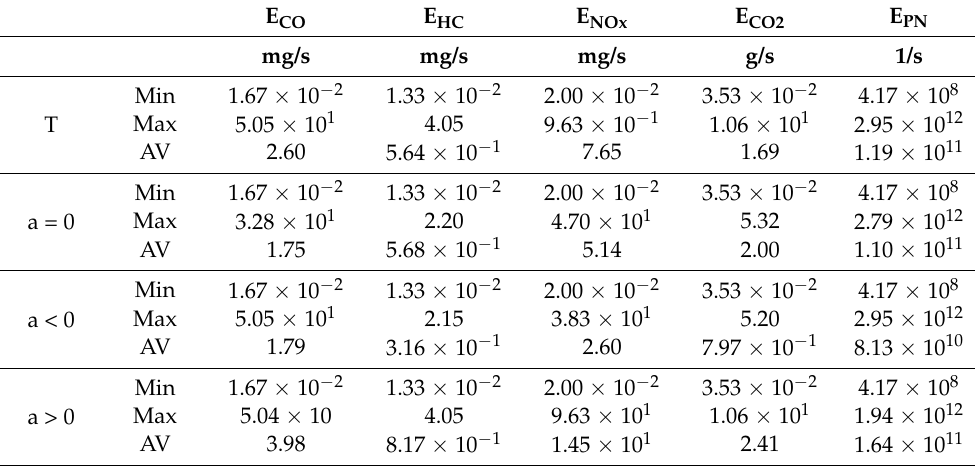
Table 3. Dimensionless characteristics of exhaust emission concentration and the particle number in the analyzed states of the RDE test: T—entire test, Min—minimum value, Max—maximum value, AV—mean